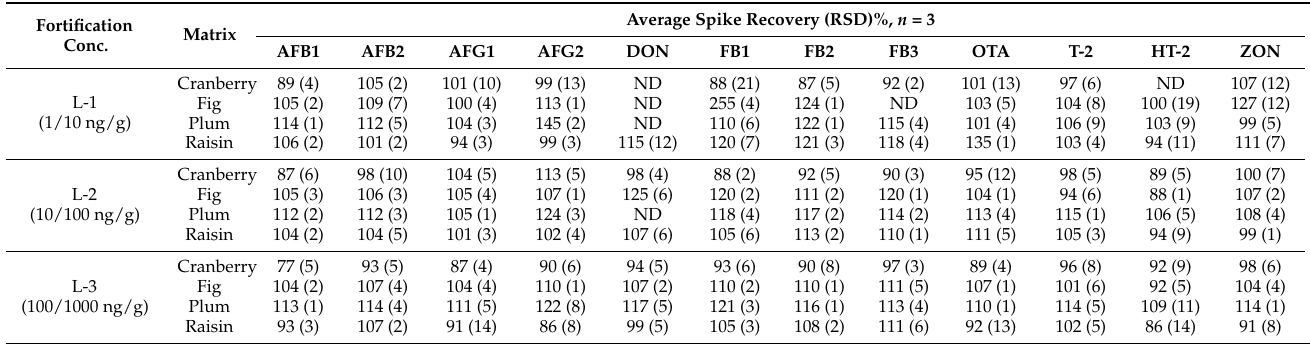
Table 2. Average spike recoveries of target mycotoxins in dried fruit